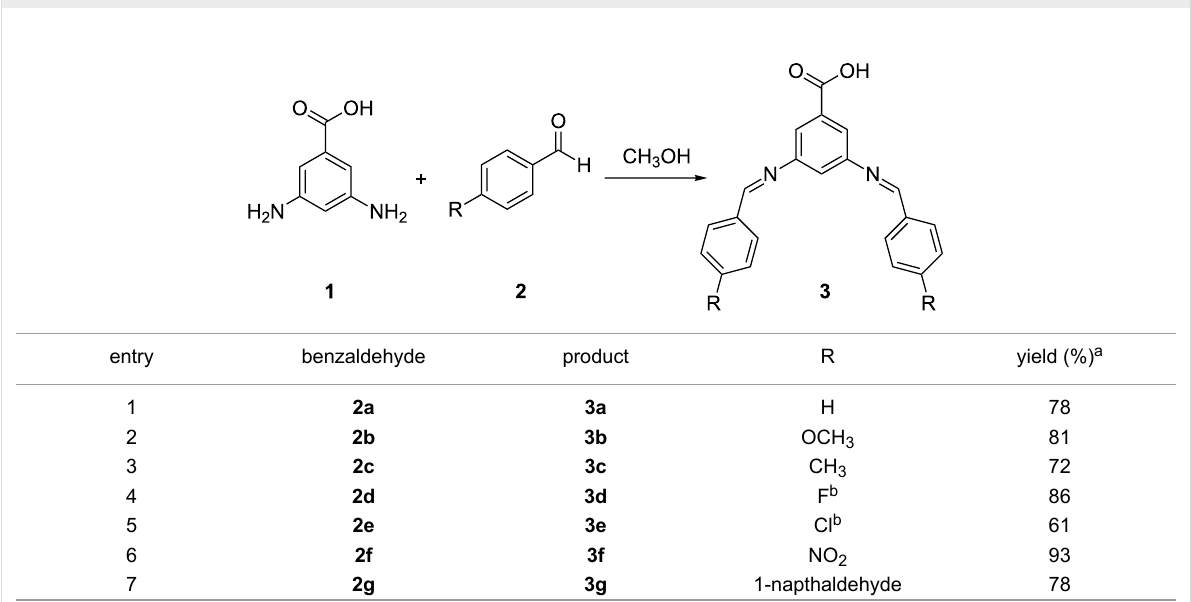
Table 1: Formation of bisimine compounds 3a – g